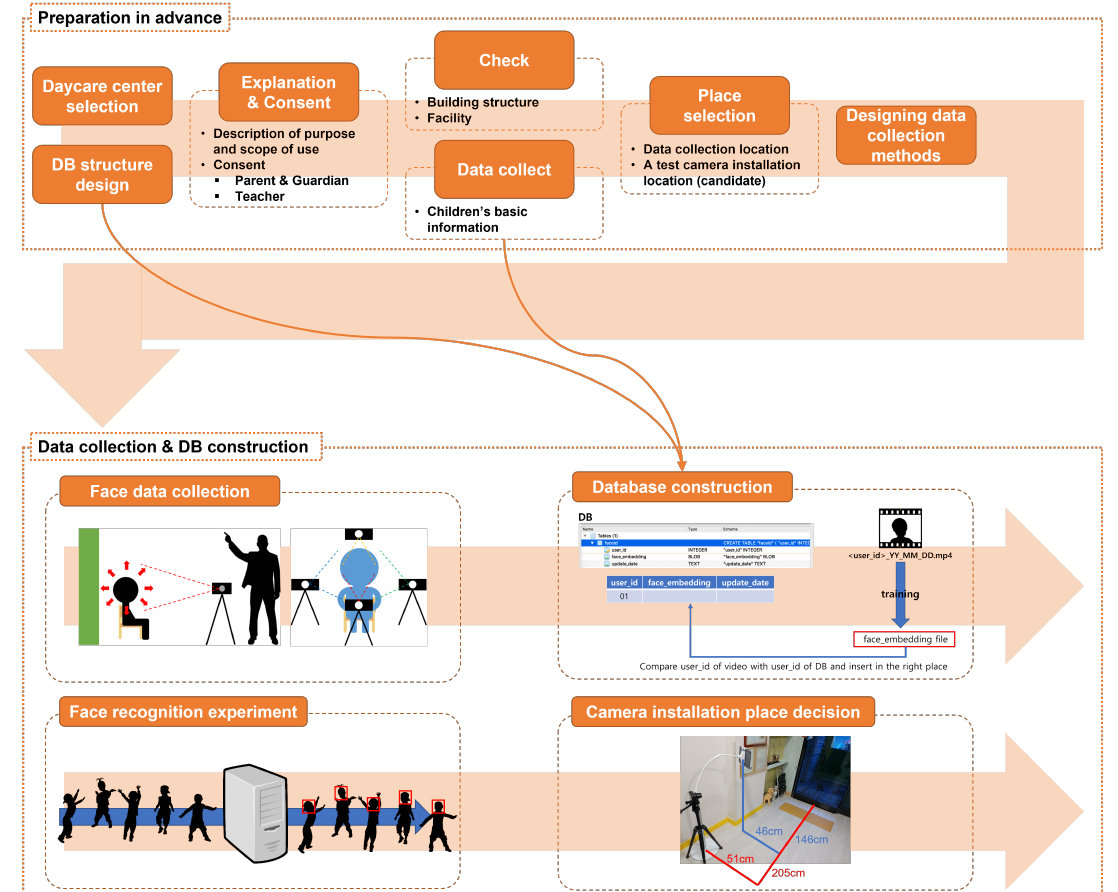
Figure 1. Data collection process flow